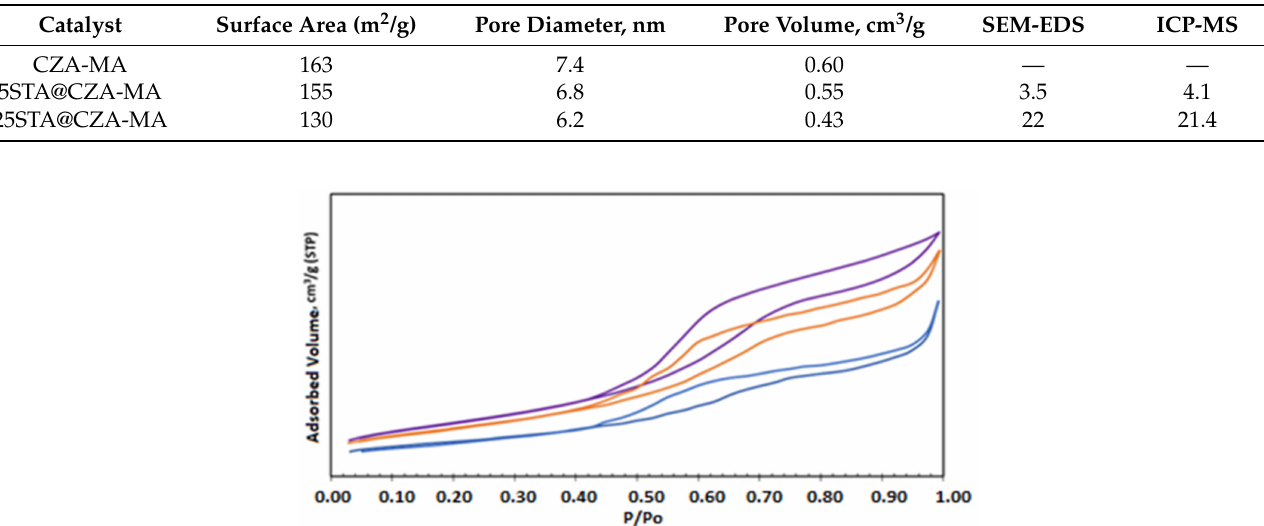
Table 1. Some physical properties of STA incorporated core-shell model catalysts.